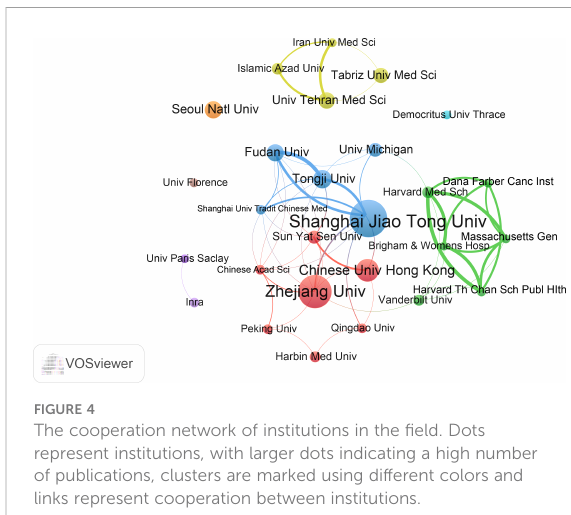
FIGURE 3 The cooperation network of countries/regions in the fi eld. Dots represent countries, with larger dots indicating a high number of publications, clusters are marked using different colors and links represent cooperation between countries.